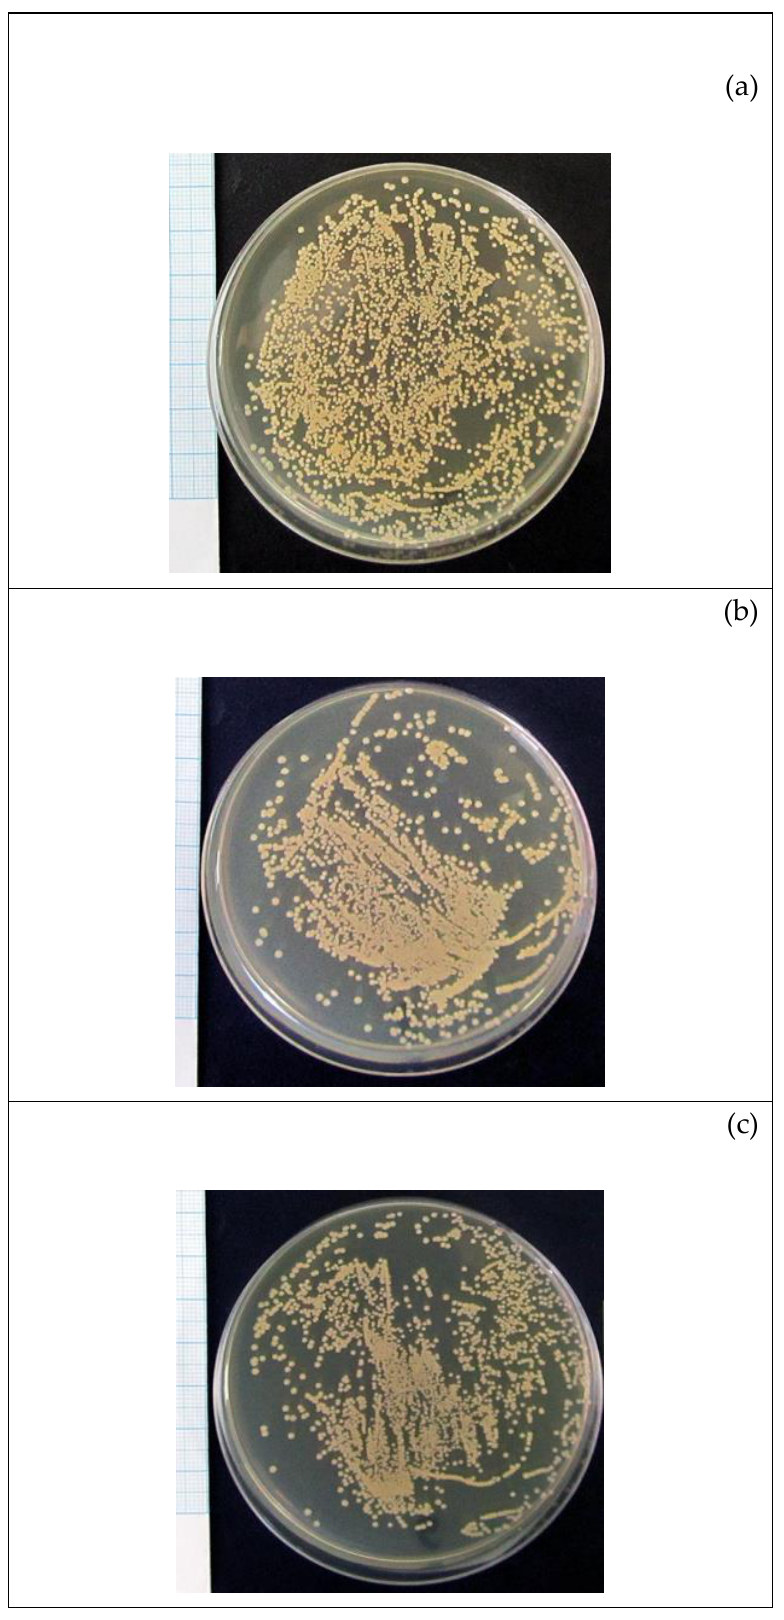
Figure 3. Results of growth of S. aureus strain 209P for 24 h after spending 24 h in a preliminary mixture with: ( a ) 0.9% NaCl solution (control); ( b ) F-SC; ( c ) PS-SC at a dose of 6.25 and 25 g/L, respectively.